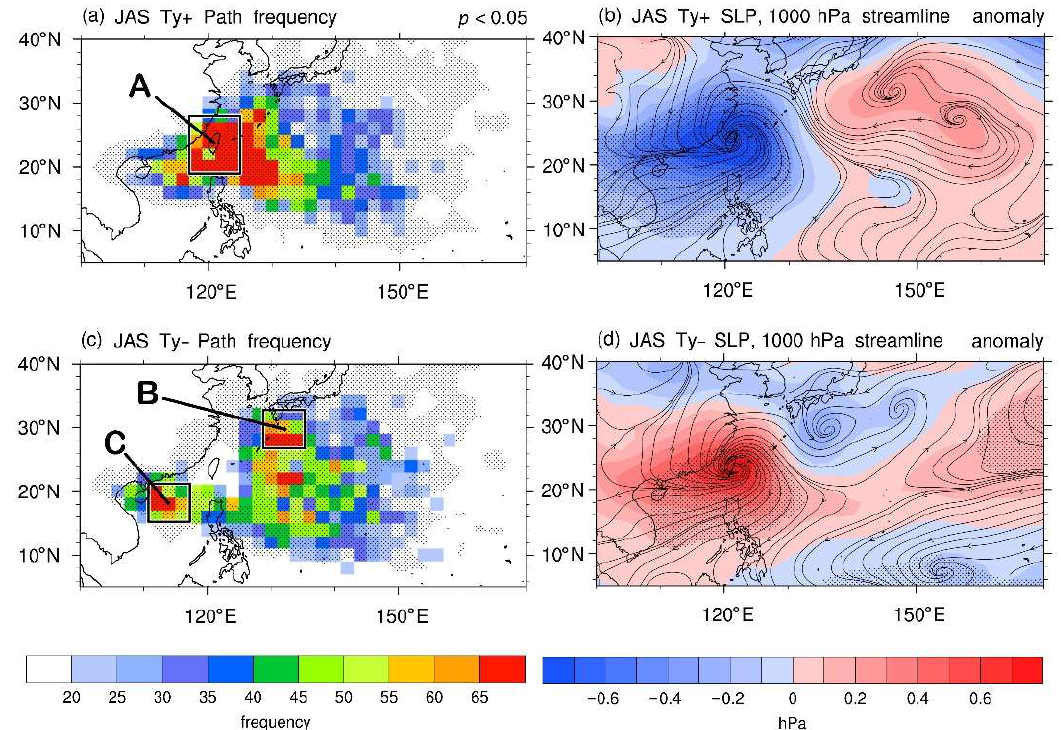
Figure 3. ( a ) Typhoon passing frequency for the Ty + category. ( b ) Sea level pressure (SLP) anomaly (unit: hPa) and 1000 hPa streamline anomaly for the Ty + category. ( c ) Same as ( a ) but for the Ty − category. ( d ) Same as ( b ) but for the Ty − category. The black box in ( a ) shows the typhoon verification domain A, and the black boxes in ( c ) show the verification domains B and C for typhoon path categorization. The dots denote areas passing a 95% confidence level.